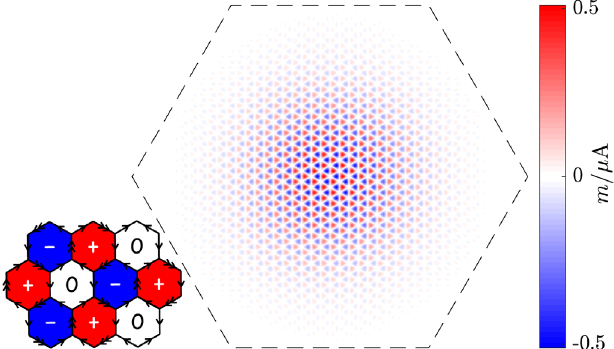
FIG. 1. Circulating currents and magnetization of the K-IVC state. Similar to a Kekule distortion, spontaneous intervalley coherence between the K − K 0 points of the graphene triples the graphene unit cell. The amplitude of the circulating current slowly modulatesoverthemoir´eunitcell,shownhereasthemagnetization density m ð r Þ , while preserving the moir´e superlattice translations. We show the contribution from a single spin species summed over the two layers; the other spin carries either identical or reversed currents if the K-IVC state is a spin singlet or spin “ triplet, ” respectively. The lower-left inset shows an example of the circulat- ing current pattern that retains C 2 T symmetry, at the scale of the graphene lattice, in the AA region of the moir´e unit